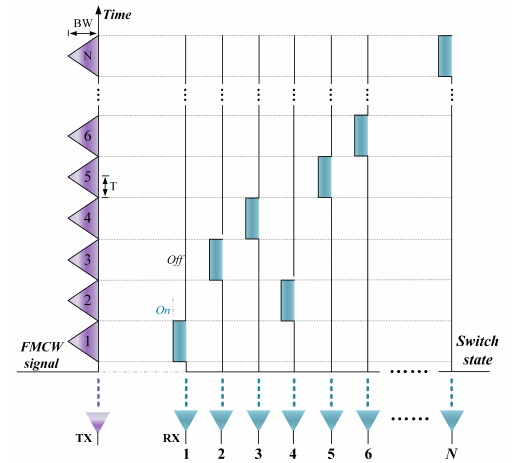
Figure 3. Timing diagram of specific switching